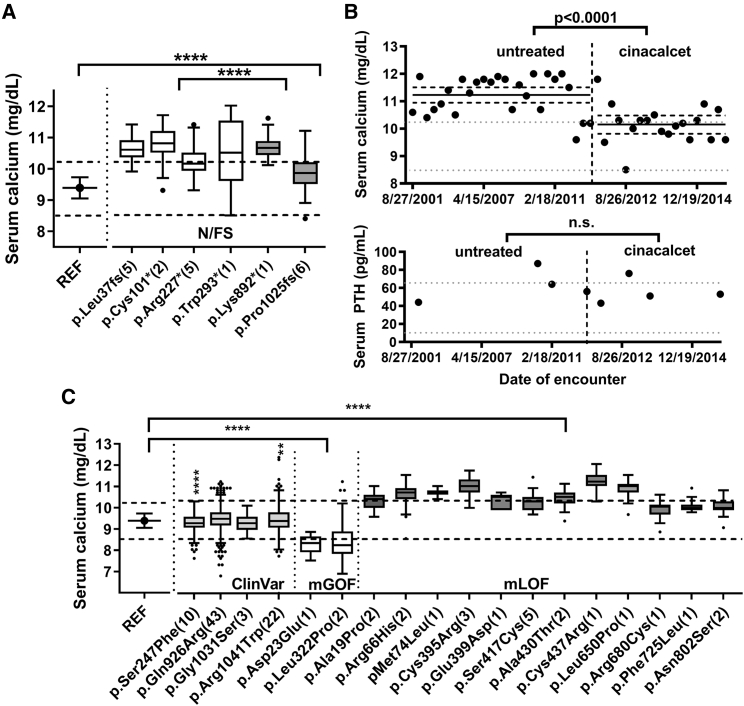
Serum Ca Concentrations for Individuals Having LoF or Rare Missense Variants in the DiscovEHR Cohort(A) Box and whisker plot in the style of Tukey (points indicating outliers) of all serum Ca measures from the EHR summed for all individuals having the same nonsense or frameshift variant (# of individuals). White boxes indicate variants predicted to undergo NMD, gray boxes indicate variants predicted to escape NMD, and dotted lines mark the normal serum Ca concentration range from 8.5 to 10.2 mg/dL. Also plotted is the mean ± SD of all individuals (15,922) having no rare variants but homozygous for the reference (REF) haplotype (Ala986/Arg990/Glu1011, residue numbering corresponding to GenBank: NM_000388.4). ∗∗∗∗p < 0.0001.(B) Upper plot presents the time series of serum Ca measures for an individual with a heterozygous Trp293∗ variant, showing a significant decrease in mean total serum Ca concentrations in December 2011, when treatment with cinacalcet began, as indicated by vertical dotted line (p < 0.0001). Means and 95% confidence intervals are plotted (mean prior to cinacalcet initiation, 11.23 ± 0.69 mg/dL, 95% C.I., 10.95–11.5 mg/dL; after cinacalcet initiation, 10.15 ± 0.69 mg/dL, 95% C.I., 9.81–10.48 mg/dL). Cinacalcet was continued through the beginning of 2015 and had a statistically significant effect on serum Ca concentrations (p < 0.0001). Lower plot indicates serum PTH values determined before and after cinacalcet initiation; differences in mean values were not significant.(C) Serum Ca means (box and whiskers in style of Tukey with points indicating outliers) were plotted for individuals homozygous for the REF haplotype (15,922 individuals), and carriers of ClinVar and rare missense CASR variants that affect serum Ca concentrations (residue numbering according to GenBank: NM_000388.4). The number of carriers of each variant having serum Ca measures in the EHR are noted in parentheses. Dotted lines mark the normal range for serum calcium (8.5–10.2 mg/dL). Statistically significant differences between groups was determined by ANOVA (∗∗p < 0.01, ∗∗∗∗p < 0.0001).